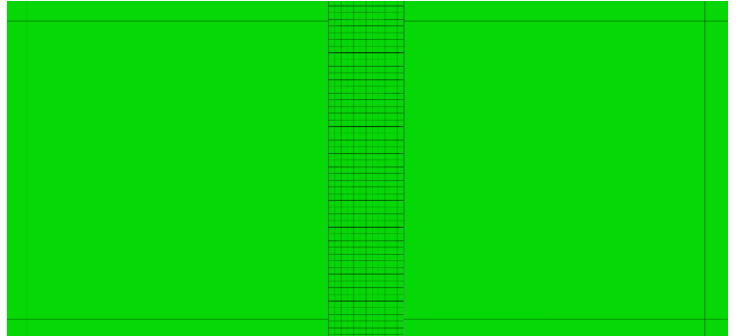
Figure 3. Close-up image of the mesh of the sub-laminate layer that was used in the CZS